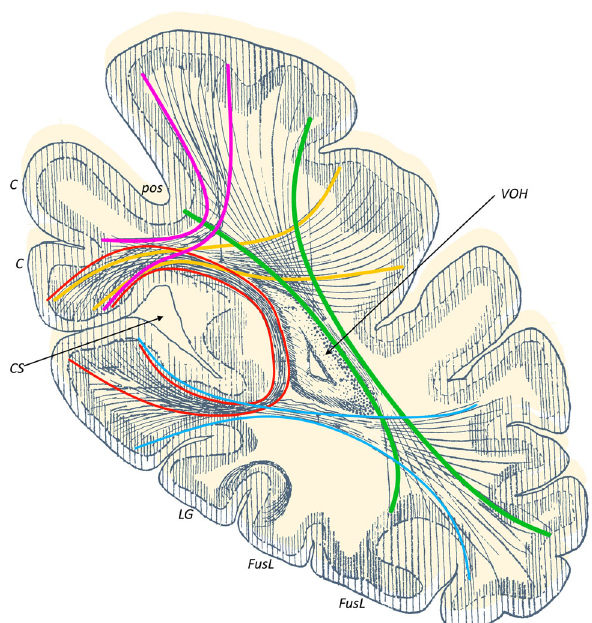
Fig. 1 The Dejerines ’ intraoccipital fi bres. A coronal slice of the occipital lobe depicting the fi ve occipital intralobar fi bres identi fi ed by Dejerine. Green, vertical occipital fasciculus; blue, transverse fasciculus of the lingual lobule of Vialet; red, stratum calcarinum; magenta, stratum proprium cunei; yellow, transverse fasciculus of the cunei; C cuneus, CS calcarine sulcus, LG lingual gyrus, FusL fusiform lobule, pos parieto-occipital sulcus, VOH occipital horn of the lateral ventricle. Image adapted and reproduced from the illustration by H. Gillet in Dejerine & Dejerine (1895, p. 781).